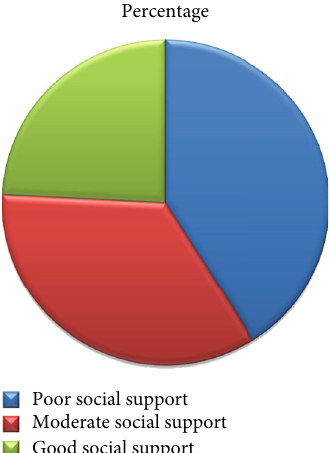
Figure 1: Distribution of the level of social support among high school students at Aksum town, 2019 ( n = 624 ).